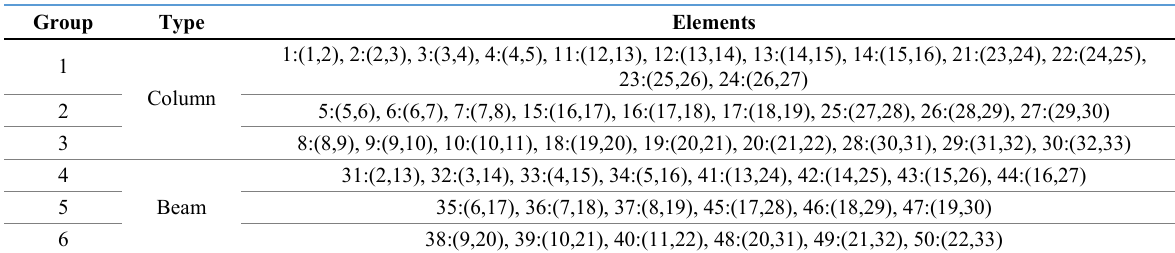
Table 5. Division of the structure into